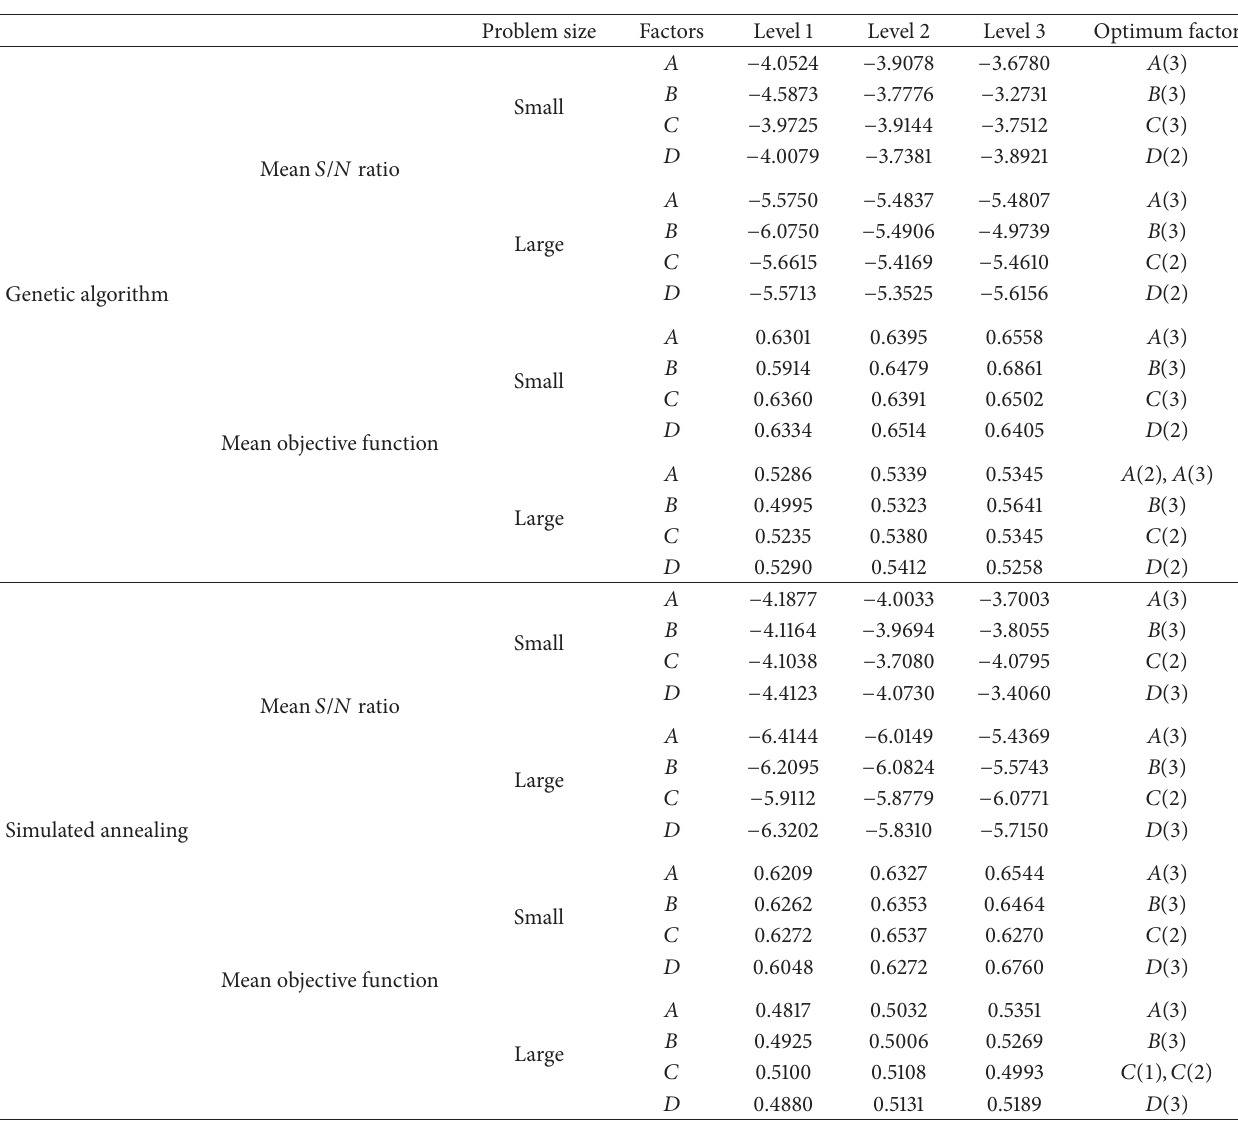
Table 6: The optimum factor for genetic algorithm and simulated annealing.